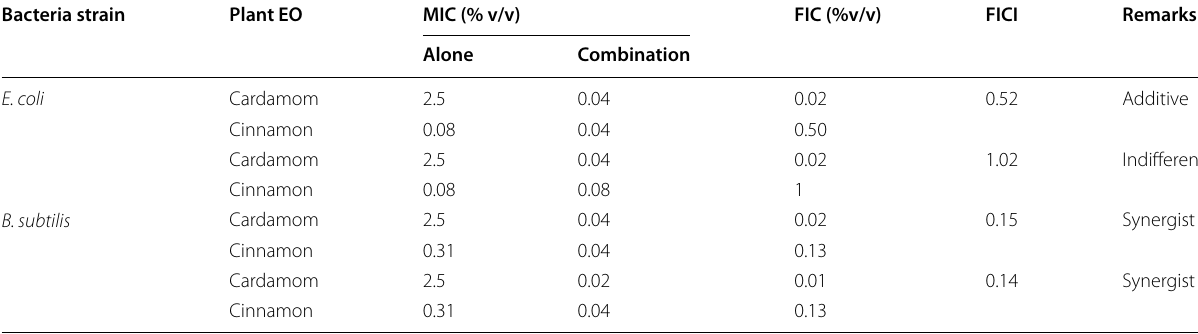
Table 2 FIC, FIC index and the results of interaction of cardamom and cinnamon essential oils combinations against E. coli and B. subtilis Bacteria strain